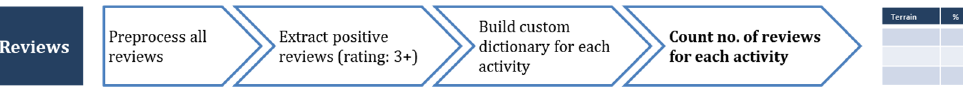
Figure 7. Big data analytics process flow of reviews for thematic TRS.